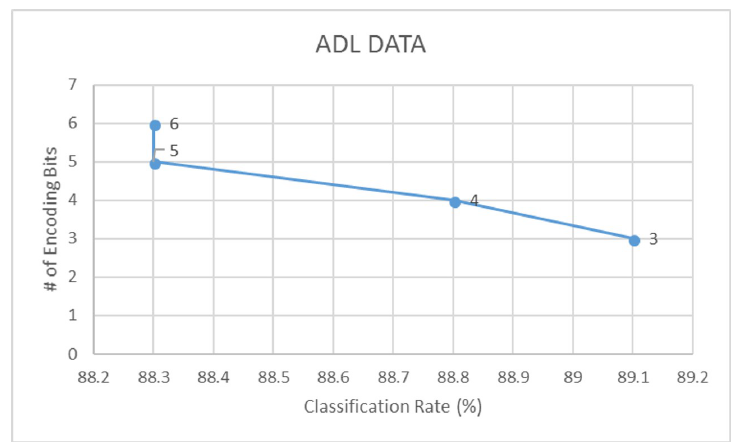
Figure 11. Classification rate vs. encoding - ADL data.